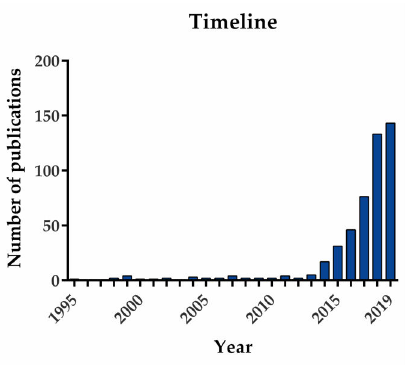
Figure 1. Timeline of released publications containing “LncRNA AND ovarian cancer” in PubMed online